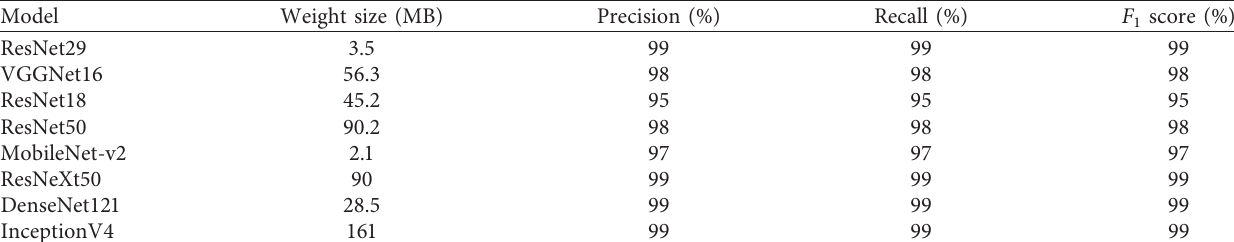
Figure 12: Muskmelon stages of maturity classification based on converted model through mobile application. (a) Green class. (b) White class. (c) Yellow class. (d) Inference time. Table 7: Comparison of classification results of different